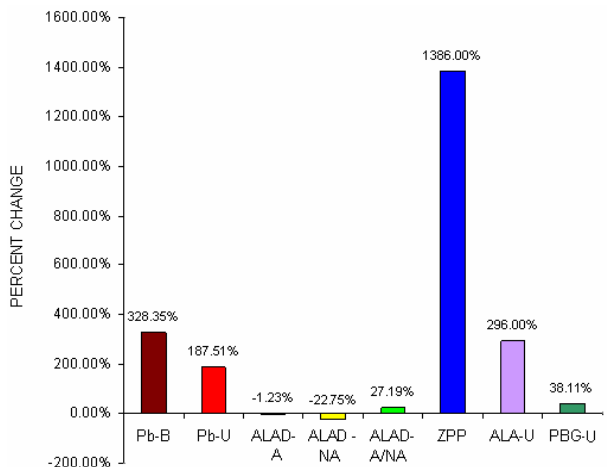
Figure 1: Percent change chart of lead concentration in blood (Pb-B), lead concentration in urine (Pb-U), activated erythrocyte d- aminolevulinic acid dehydratase (ALAD-A) non activated erythrocyte d- aminolevulinic acid dehydratase(ALAD- NA),activated and non activated erythrocyte d- aminolevulinic acid dehydratase ratio (ALAD-A/NA), erythrocyte- Zinc protoporphyrin (ZPP), d- aminolevulinic acid in urine (ALA-U) and Porphobilinogen in urine (PBG-U) of lead exposed battery manufacturing workers ( BMW ) group of western Maharashtra ( India ) with respect to control group.